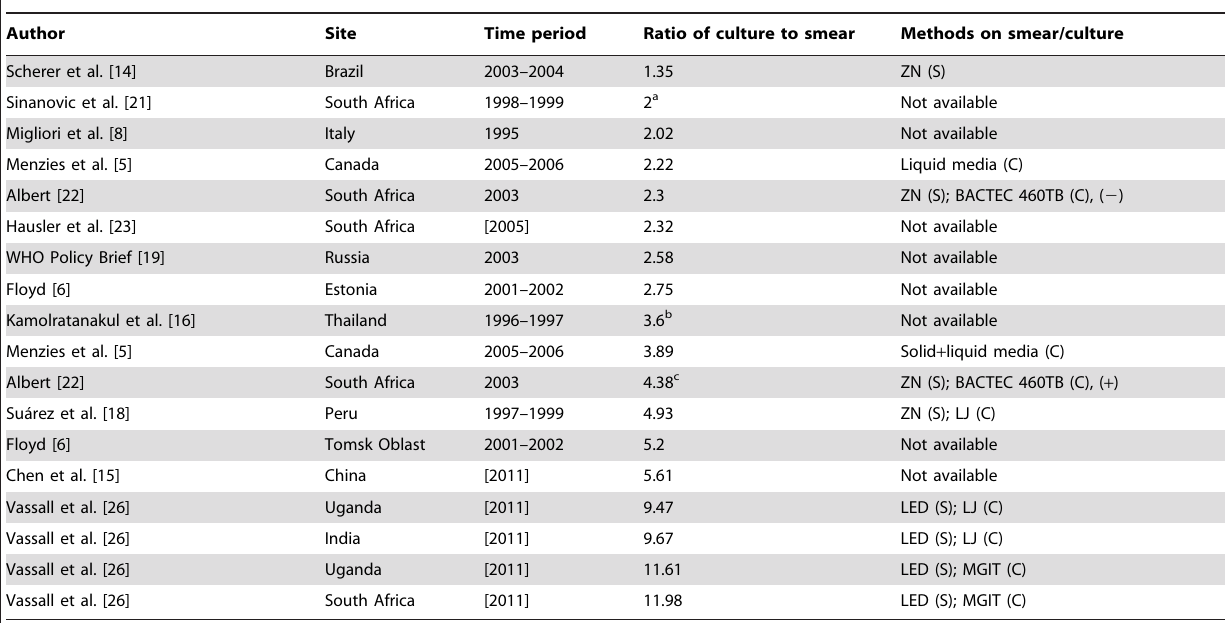
Table 3. Ratio of unit cost for culture to